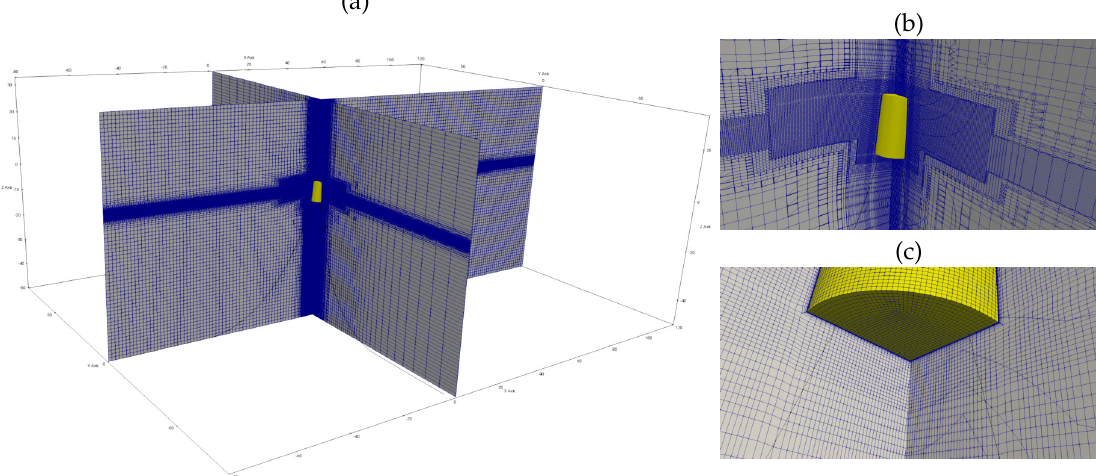
Figure 2. Overview of the discretised numerical wave tank: ( a ) global mesh; ( b ) morphing mesh region; and ( c ) discretisation of the body.